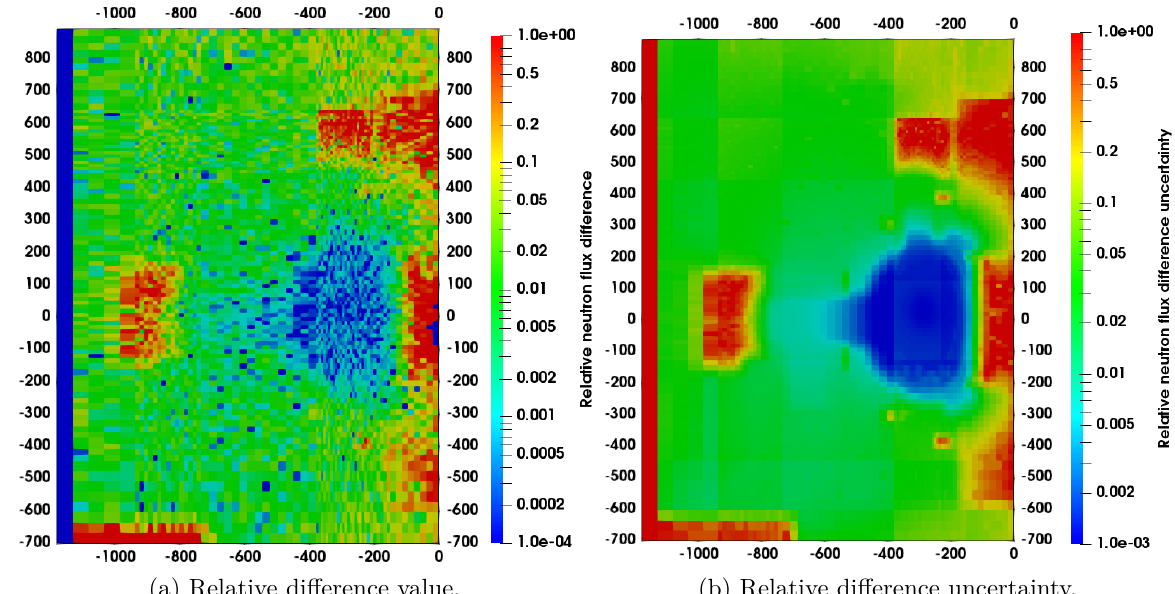
Figure 4: Relative neutron flux difference comparing analogue and FW-CADIS weight window variance reduction technique accelerated neutron fluxes: DD plasma, octant 1 with 1 × 10 9 simulated particles.